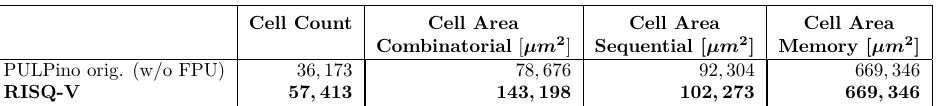
Table 8: Area ASIC synthesis (UMC 65